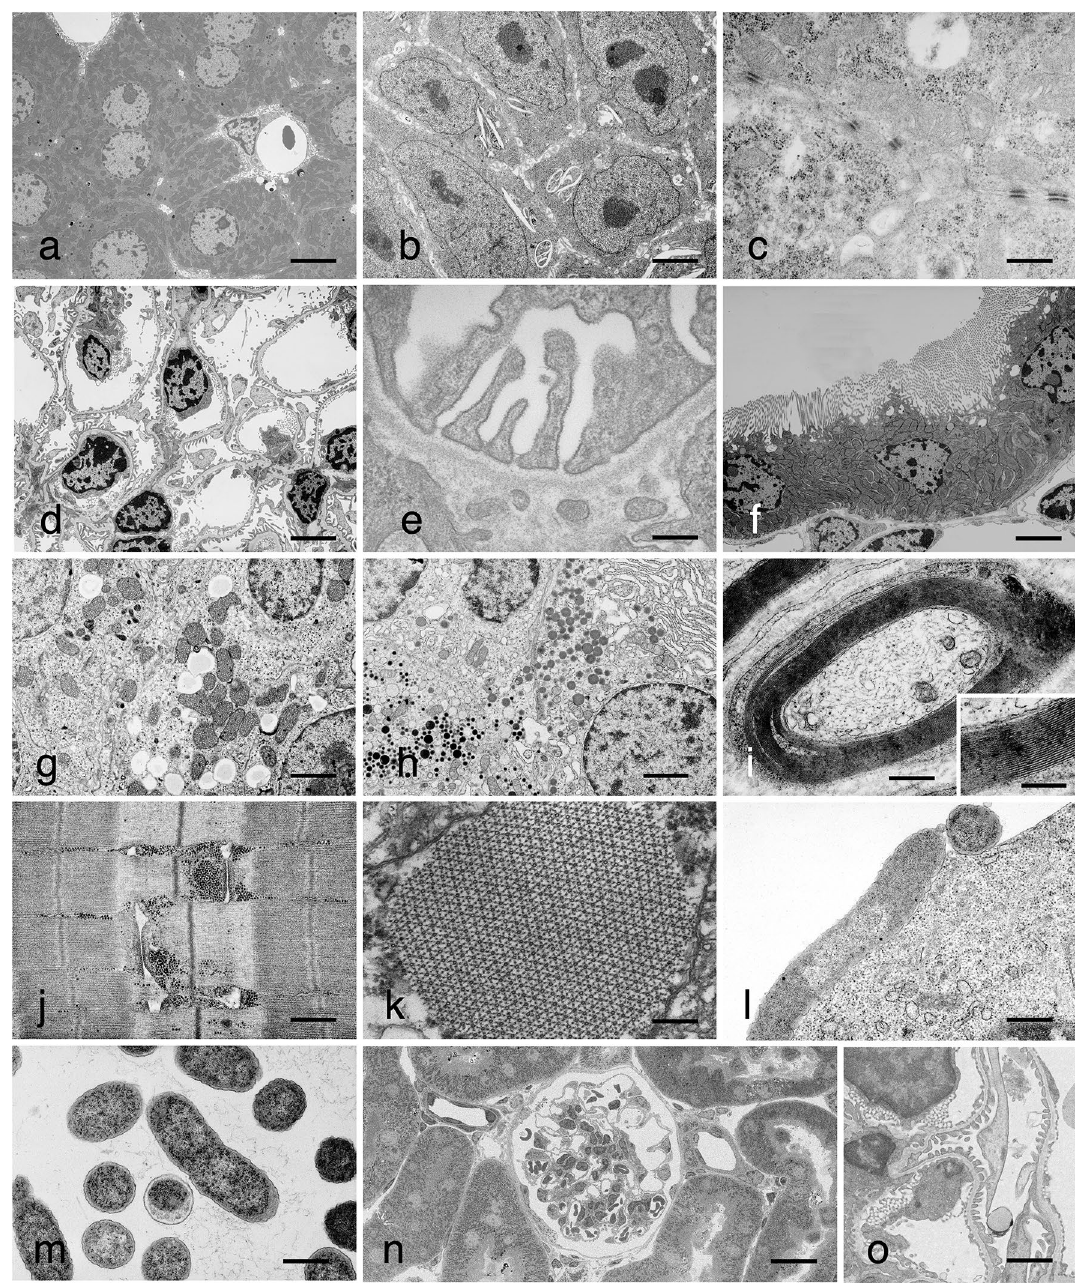
Figure 3. EM images of various kinds of cells and tissues stained with MH followed by RPb. Cells and tissues were prepared using conventional fixation, dehydration, epoxy resin embedding, and sectioning methods. Each section was stained with MH for 10 min followed by RPb for 5 min. ( a ) mouse liver, bar = 5 μm, ( b ) A6 cultured cells, bar = 3 μm, ( c ) A6 cultured cells, bar = 500 nm, ( d ) renal glomerulus, bar = 3 μm, ( e ) renal glomerulus, bar = 500 nm, ( f ) mouse renal proximal tubule, bar = 3 μm, ( g ) mouse adrenal glands, bar = 1 μm, ( h ) mouse anterior pituitary lobe, Bar = 1 μm, ( i ) mouse myelinated nerve, bar = 500 nm, inset shows the high-power view of the myelin region, bar = 200 nm, ( j ) longitudinal section of mouse skeletal muscle, bar = 500 nm, ( k ) cross section of Drosophila insect flight muscle, bar = 500 nm, ( l ) Escherichia coli -infected Ehrlich tumor cultured cells, bar = 500 nm, and ( m ) Staphylococcus aureus , bar = 500 nm. ( n , o ) Back scatter image of 200 nm semi-thin sections of mouse kidney observed with FE-SEM: ( n ) shows a low-power view of the renal cortex, bar = 10 μm and ( o ) shows the high-power view of the renal glomerulus, bar = 2 μm. MH is incorporated with little specificity into most of the normally observed tissue components, and although contrast is greatly increased, the general image with certain exceptions is similar to that obtained with UA staining. The results represent at least three independent experiments with similar